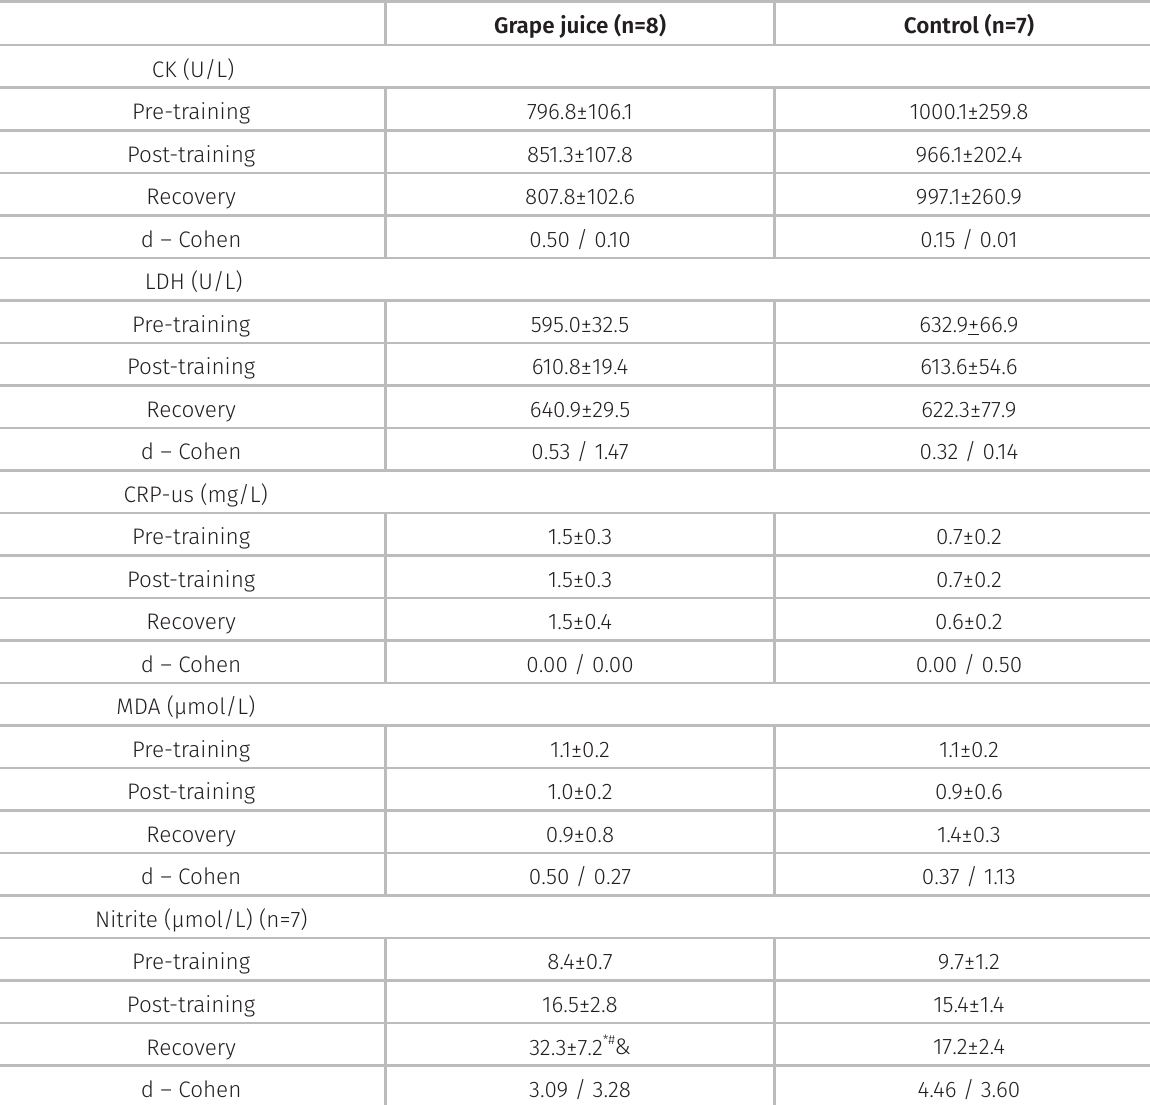
Table III. Behavior of blood markers at pre-training, post-training and at the end of the recovery period